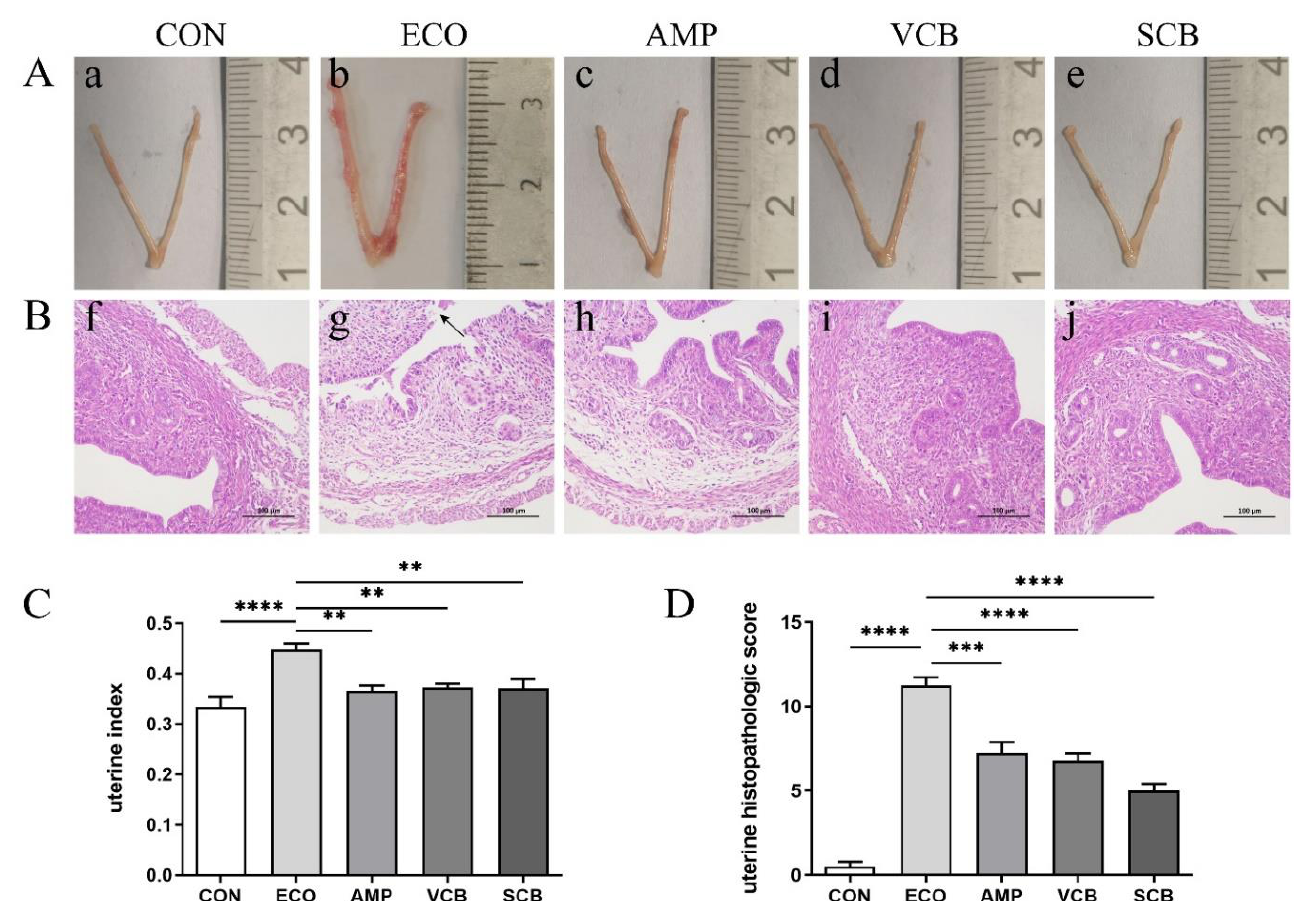
Figure 2. C. butyricum and its culture supernatant alleviated uterine morphological and histopatho- logical changes induced by E. coli . ( A ) Uterus morphology (( a ) CON; ( b ) ECO; ( c ) AMP; ( d ) VCB; ( e ) SCB). ( B ) H&E staining of uterine tissue (( f ) CON; ( g ) ECO; ( h ) AMP; ( i ) VCB; ( j ) SCB). ( C ) Uterine index. ( D ) Histopathologic scoring of the uterine tissue. The values presented are the means ± SEM ( n = 6). ** p < 0.01, *** p < 0.001, and **** p < 0.0001 are significantly different from ECO.